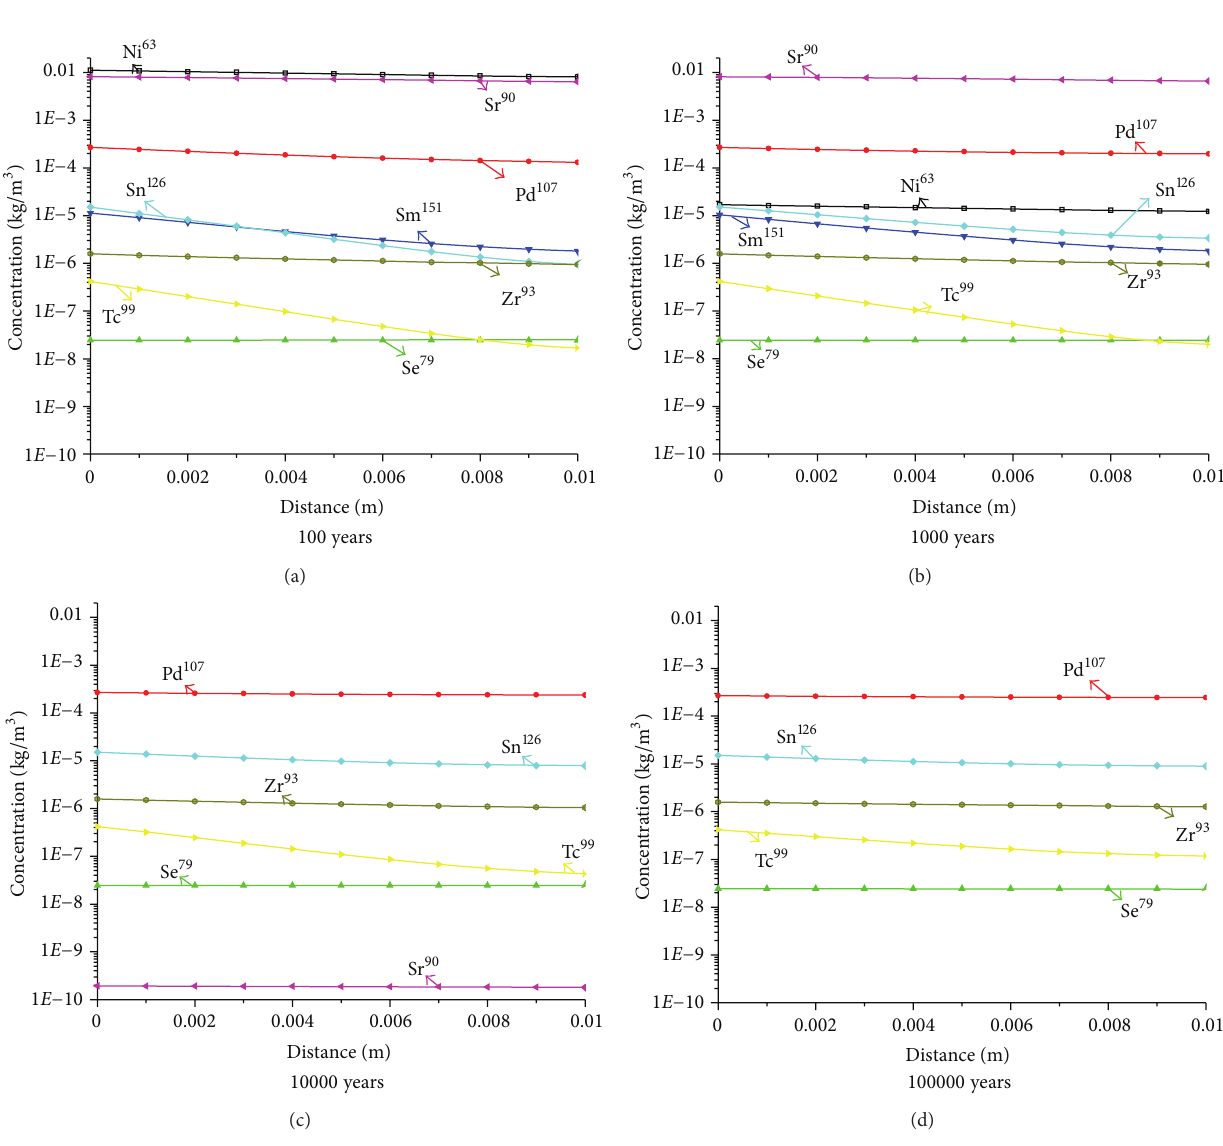
Figure 6: Concentration profiles in extruded bentonite region for 10 2 , 10 3 , 10 4 , and 10 5